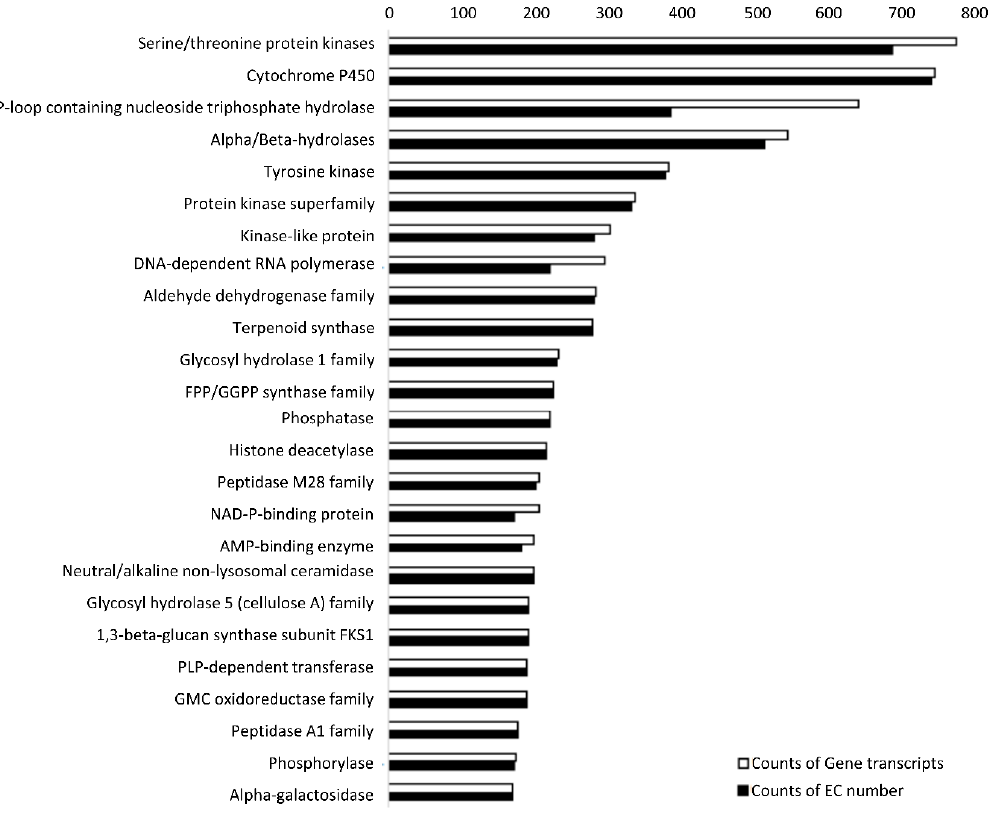
Figure 4. Annotation of the Armillaria sinapina putative proteins using the Kyoto encyclopedia of genes and genomes